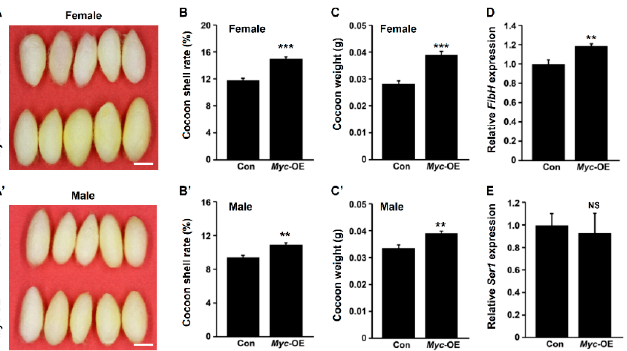
Figure 2. Enhanced Myc expression in the PSG elevates silk yield. ( A , A ’) Cocoon size of female ( A ) and male ( A ’) transgenic silkworms with Myc overexpression increased compared with control. Scale bar, 1 cm. ( B , C ’) The cocoon shell rates ( B , B ’) and cocoon weight ( C , C ’) were both largely increased following PSG-specific Myc overexpression. ( D , E ) Myc overexpression in the PSG promoted the transcription of FibH ( D ) but had no effect on the transcription of Ser1 ( E ). Values are represented as means ± S.E. (error bars). For the significance test: ** p < 0.01, *** p < 0.001 vs. the